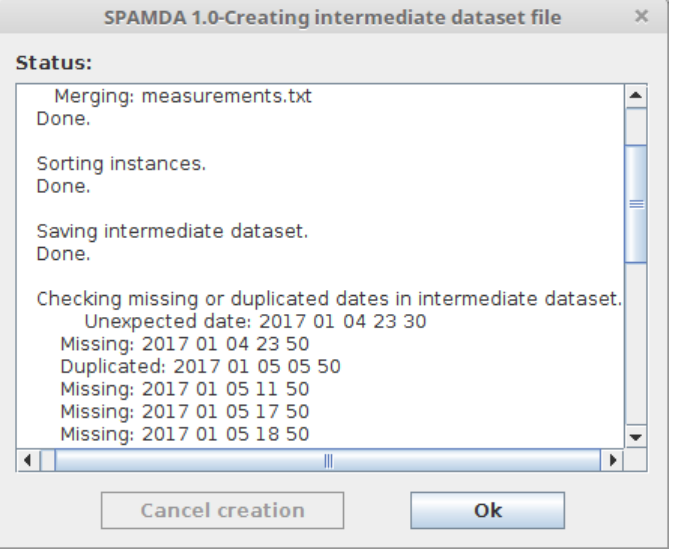
Figure A2. Status of the creation of the intermediate dataset for the example of Figure